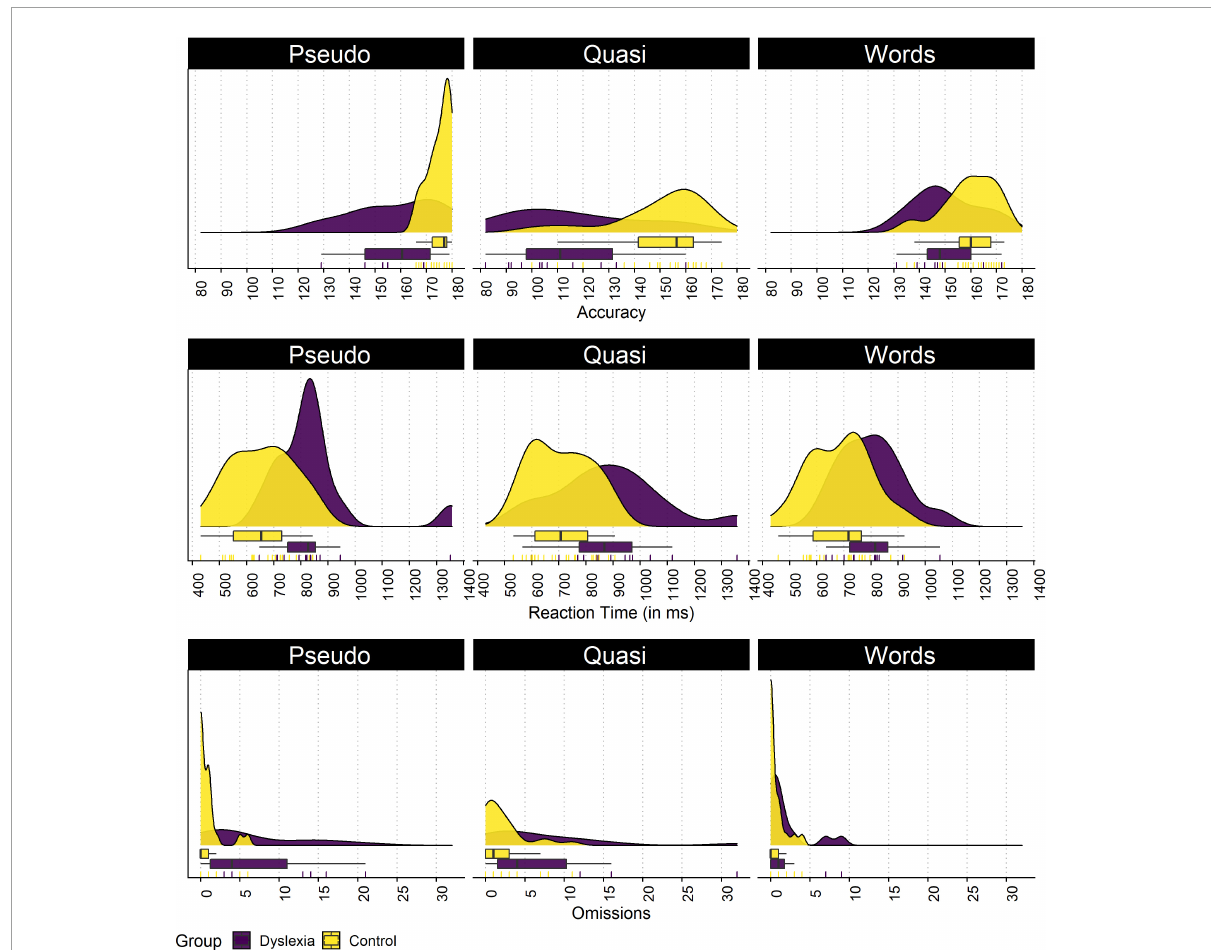
FIGURE2 Distributions of the control and dyslexia group for the total number of correct answers, the reaction time, and the total number of omissions in the lexical decision task. The density plots present the density estimate of each variable, the boxplot present the median and quartiles, and the rugs present each data point